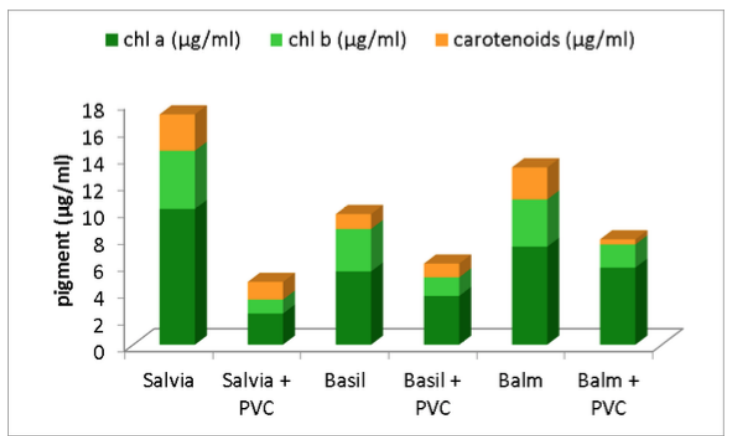
Figure 3. The chlorophyll and carotenoid content of herbs